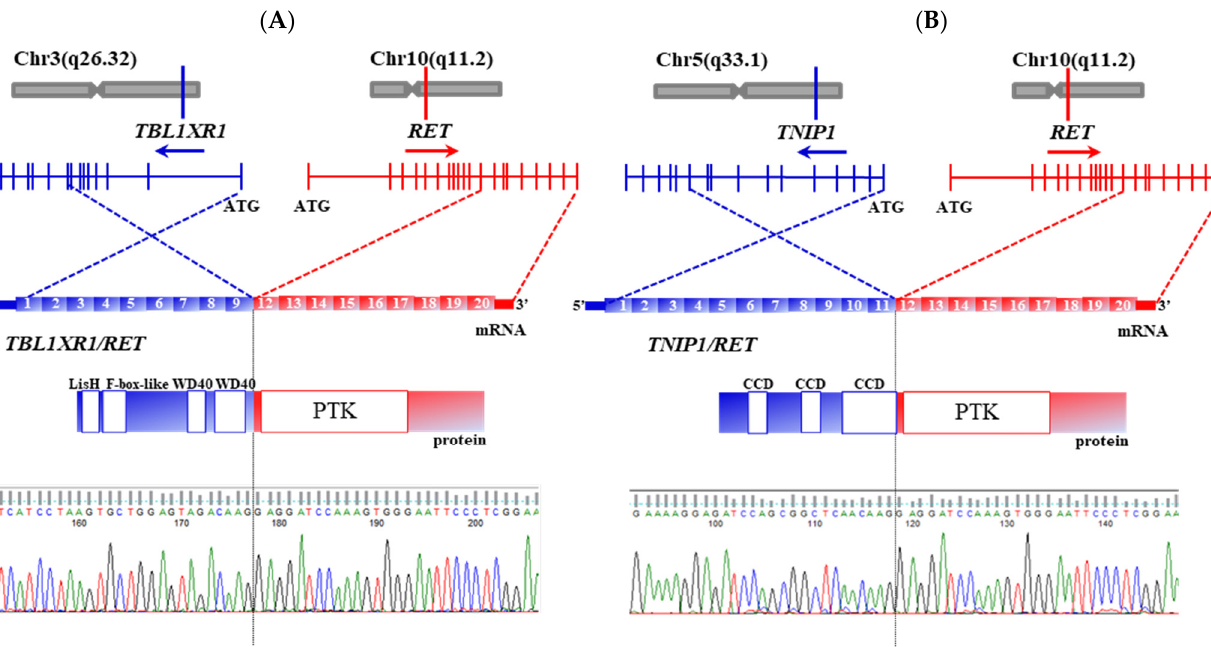
Figure 4. Characterization of the TBL1XR1/RET and TNIP1/RET fusions. ( A ) Genomic location, mRNA and protein structure, and validation by Sanger sequencing of TBL1XR1/RET . Exons 1 – 9 of TBL1XR1 are shown in blue and exons 12 – 20 of RET are shown in red for mRNA. For protein: LisH (lissencephaly type-1-like homology) domain, a dimerization motif; F-box-like, mediates protein – protein interactions; WD40, mediates protein – protein interactions; PTK, protein tyrosine kinase. ( B ) Genomic location, mRNA and protein structure, and validation by Sanger sequencing of TNIP1/RET . Exons 1 – 11 of TNIP1/RET are shown in blue and exons 12 – 20 of RET are shown in red for mRNA. For protein: CCD — coiled coil domain, mediates homodimerization; PTK, protein tyrosine kinase. Sequences of TBL1XR1/RET and TNIP1/RET are presented in Supplementary File S1 and are deposited to GenBank under accession numbers MZ269488 and MZ269489, respectively.